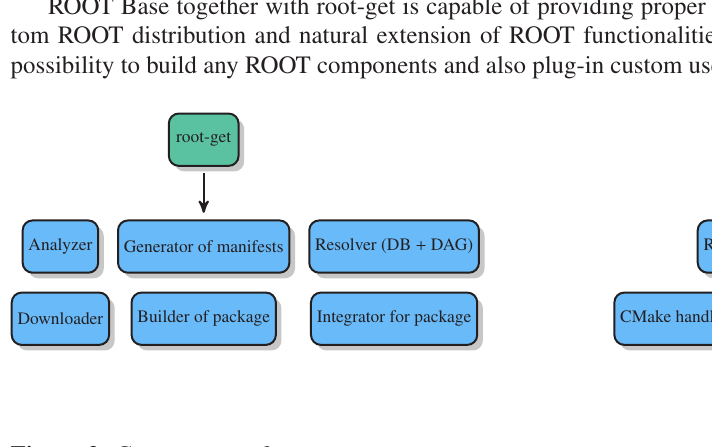
Figure 2: Components of root-get